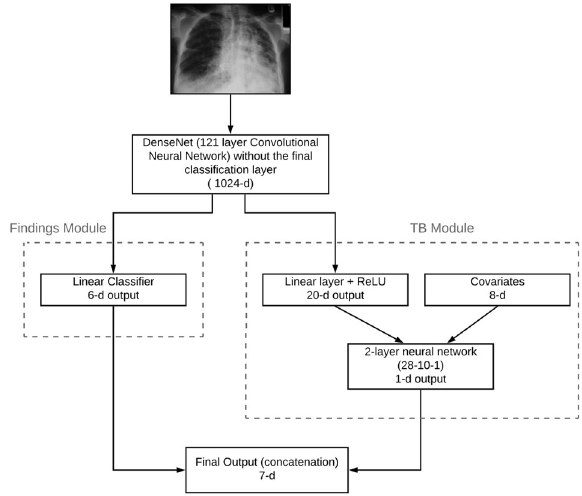
Fig. 3 Diagram of the deep learning algorithm architecture. The architecture takes both the x-ray image and 8 clinical covariates as input and predicts TB and 6 clinical fi